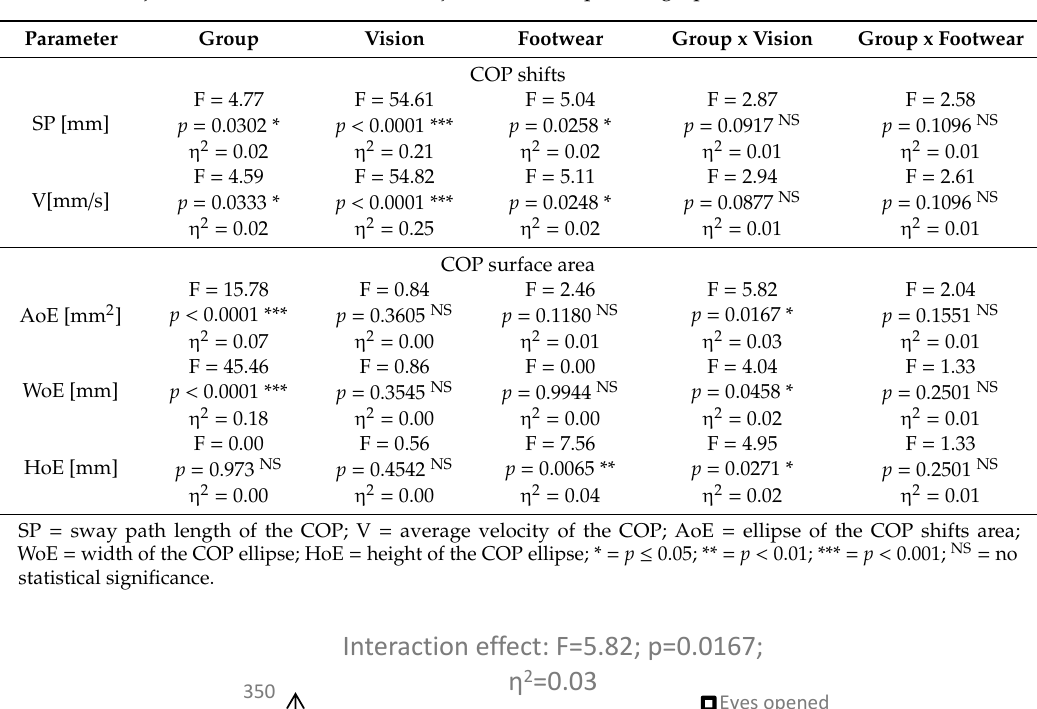
Table 2. E ff ects of the between-subject factor (group: pentathletes / controls) and two within-subject factors (vision: eyes opened, eyes closed; footwear: in footwear, barefoot) and interaction of the between-subject factor with the within-subject factors on posturographic measures.